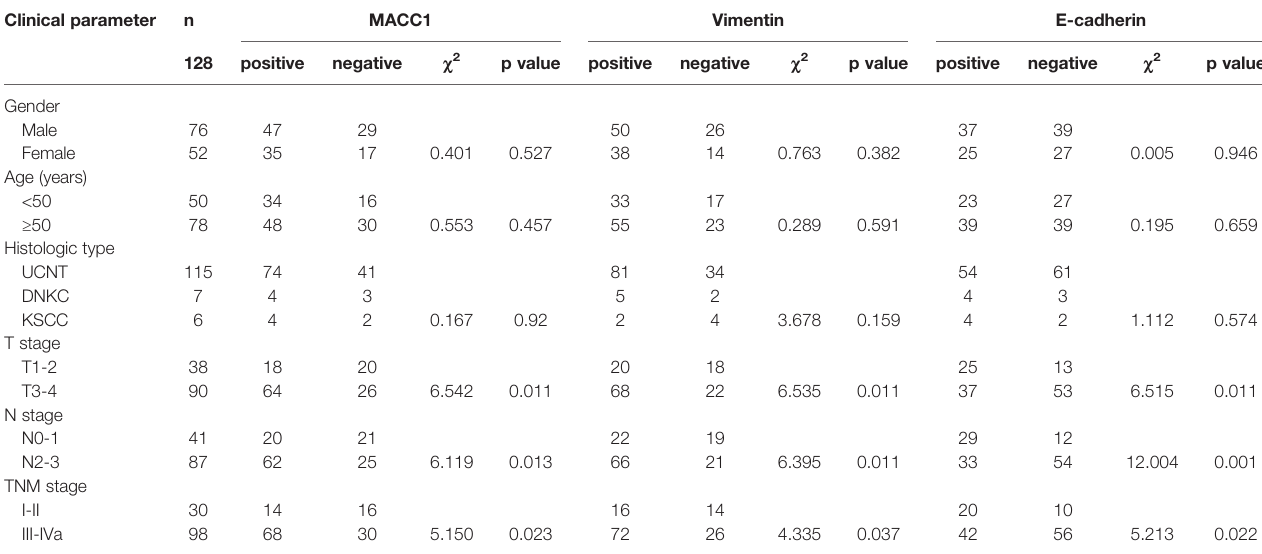
TABLE 1 | Relationship between MACC1, E-cadherin, and vimentin expression and the clinicopathological features of NPC patients. Clinical